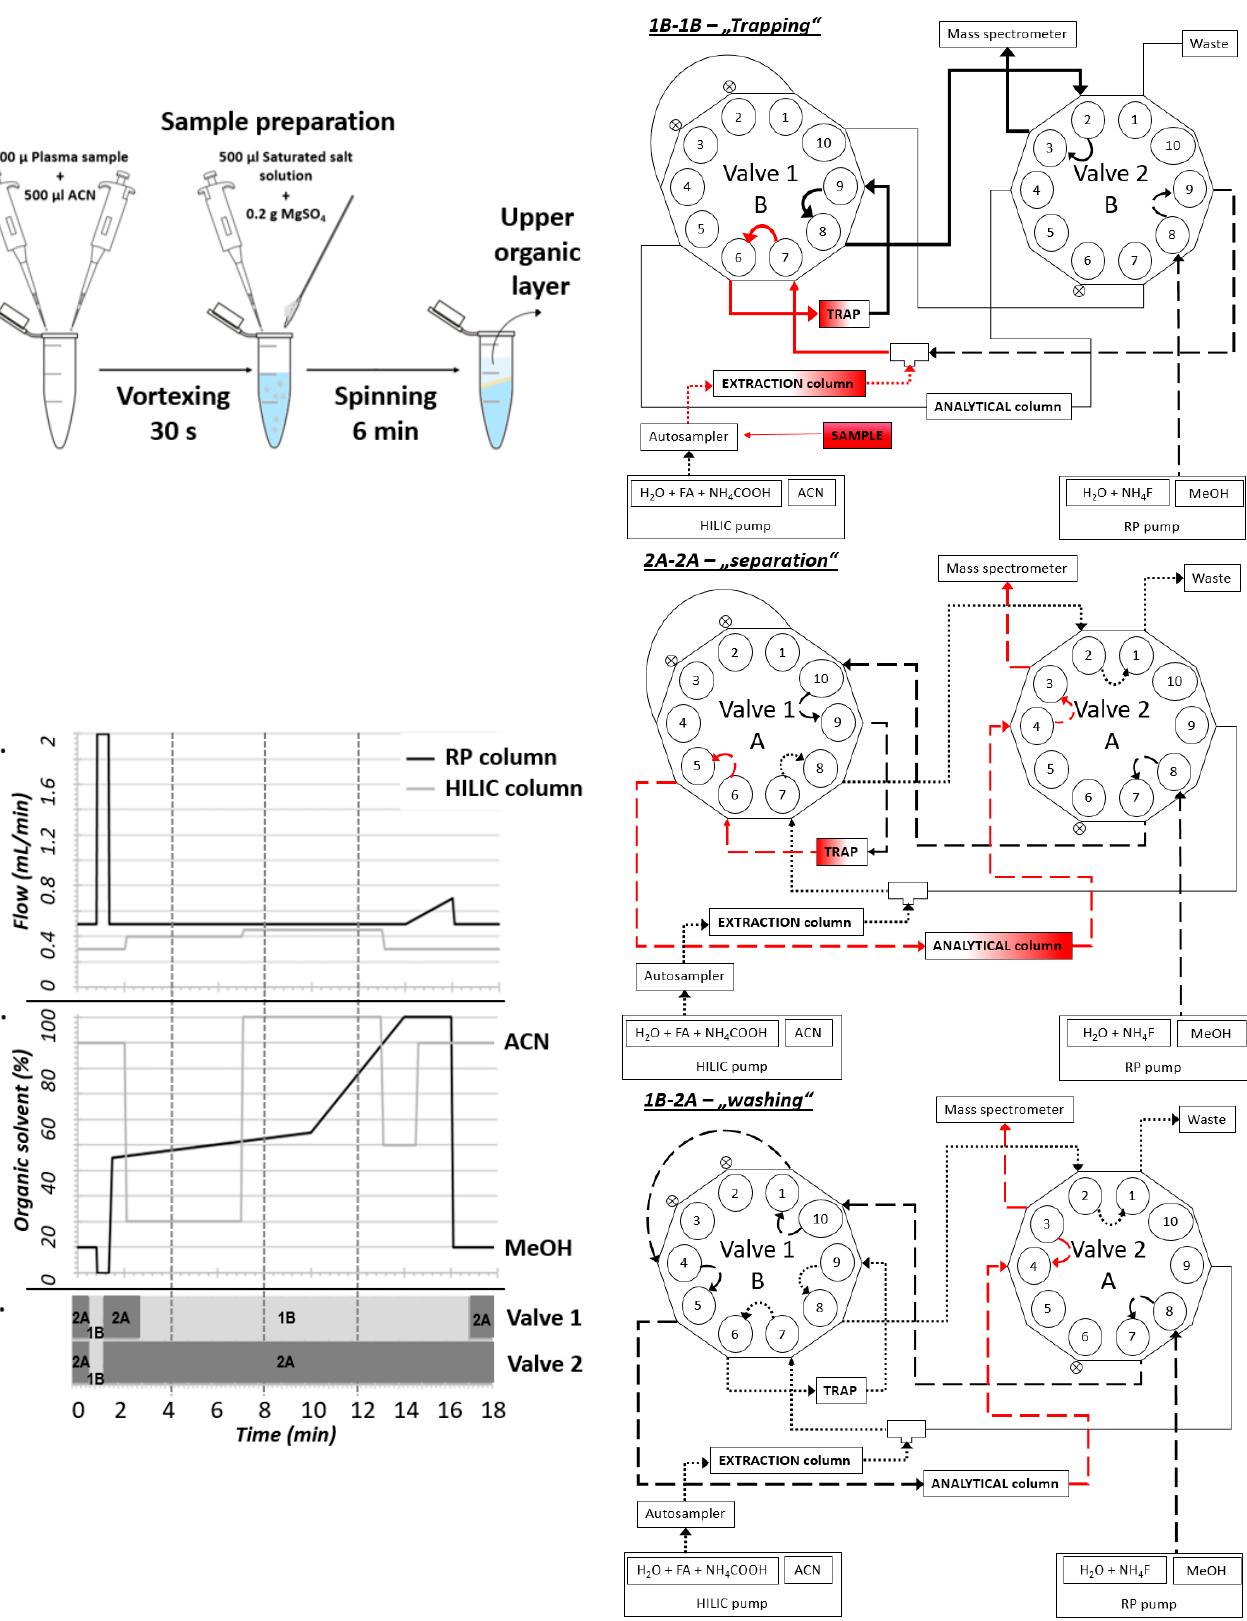
Figure 1. Analysis arrangement: The plasma sample is prepared by the modified QuEChERS-way in a two-step pre-treatment and directly injected into the system (10 min per sample). The target non-polar analytes are separated from the matrix on the extraction column (HILIC) and retained at